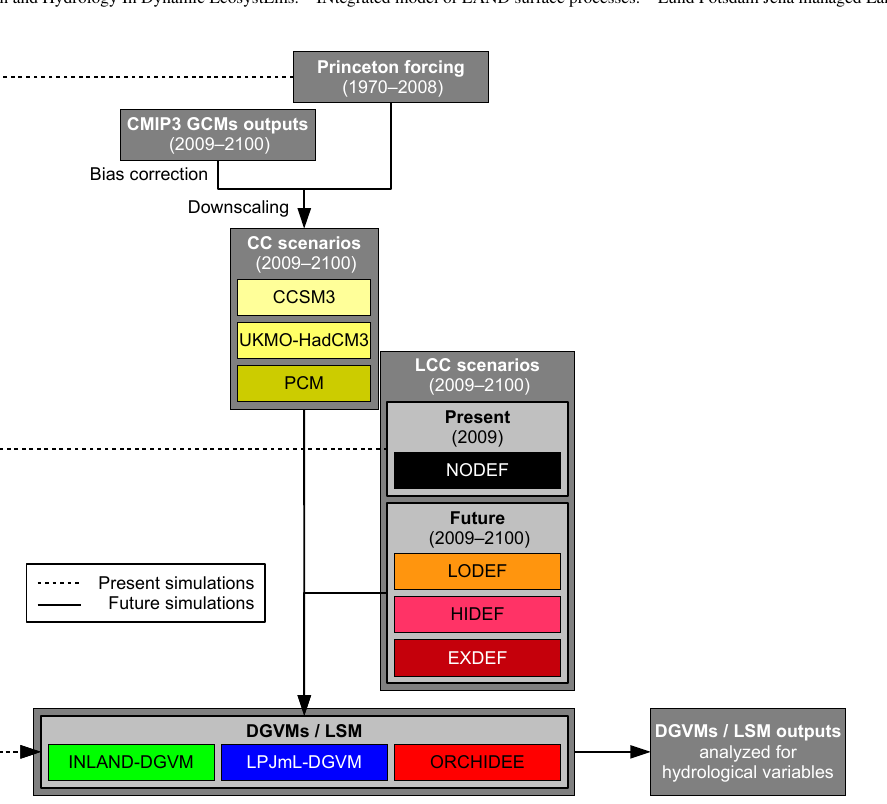
Figure 2. Flow chart methodological approach for present and future simulation processes (CC indicates climate change, LCC indicates land-cover change). Abbreviations of the LCC scenarios are explained in Table